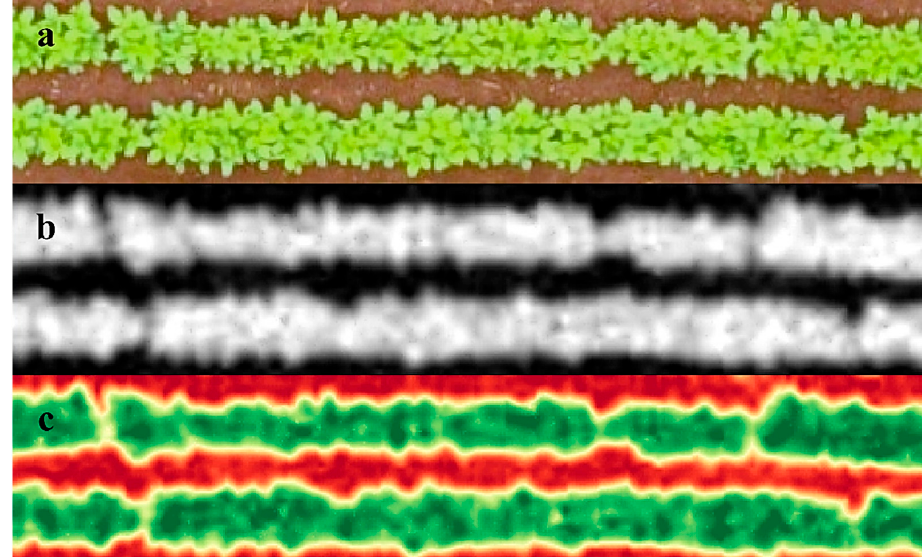
Figure 1. ( a ) Original image of an experimental plot. ( b ) Triangular greenness index image of an experimental plot. ( c ) Triangular greenness index image with red–green palette applied.